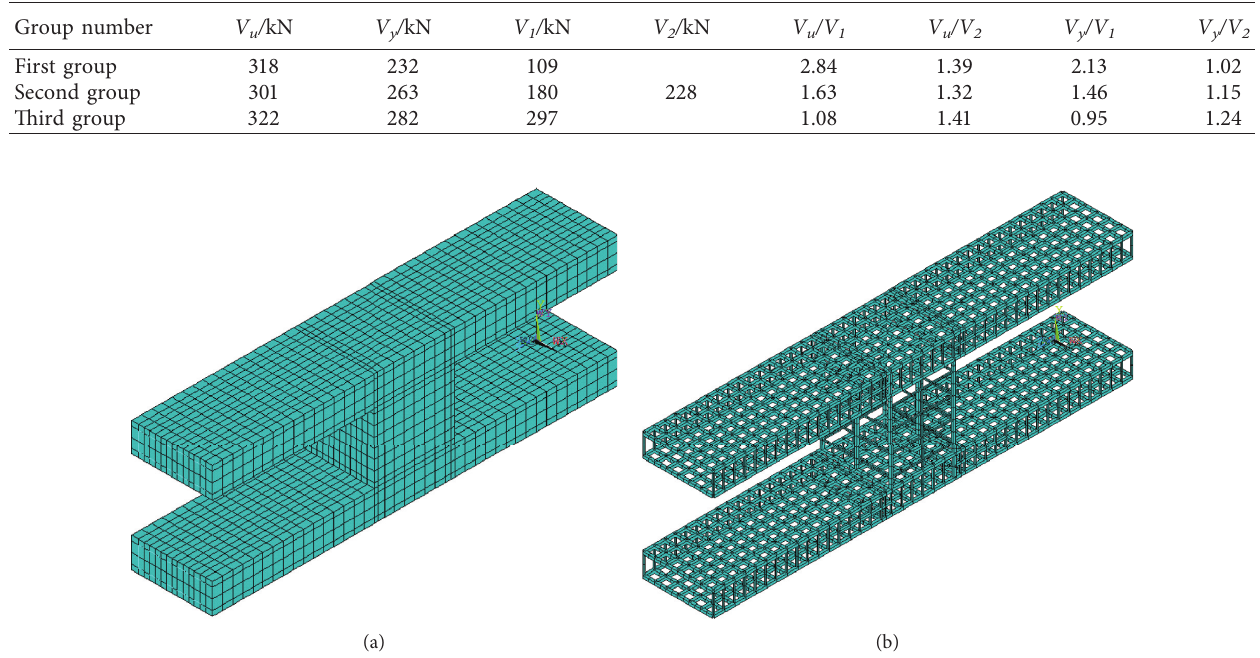
Figure 26: Finite element model diagram. (a) Model diagram. (b) Skeleton diagram of steel Table 6: The results of FEA and its ratio to the values in Tables 4 and 5.